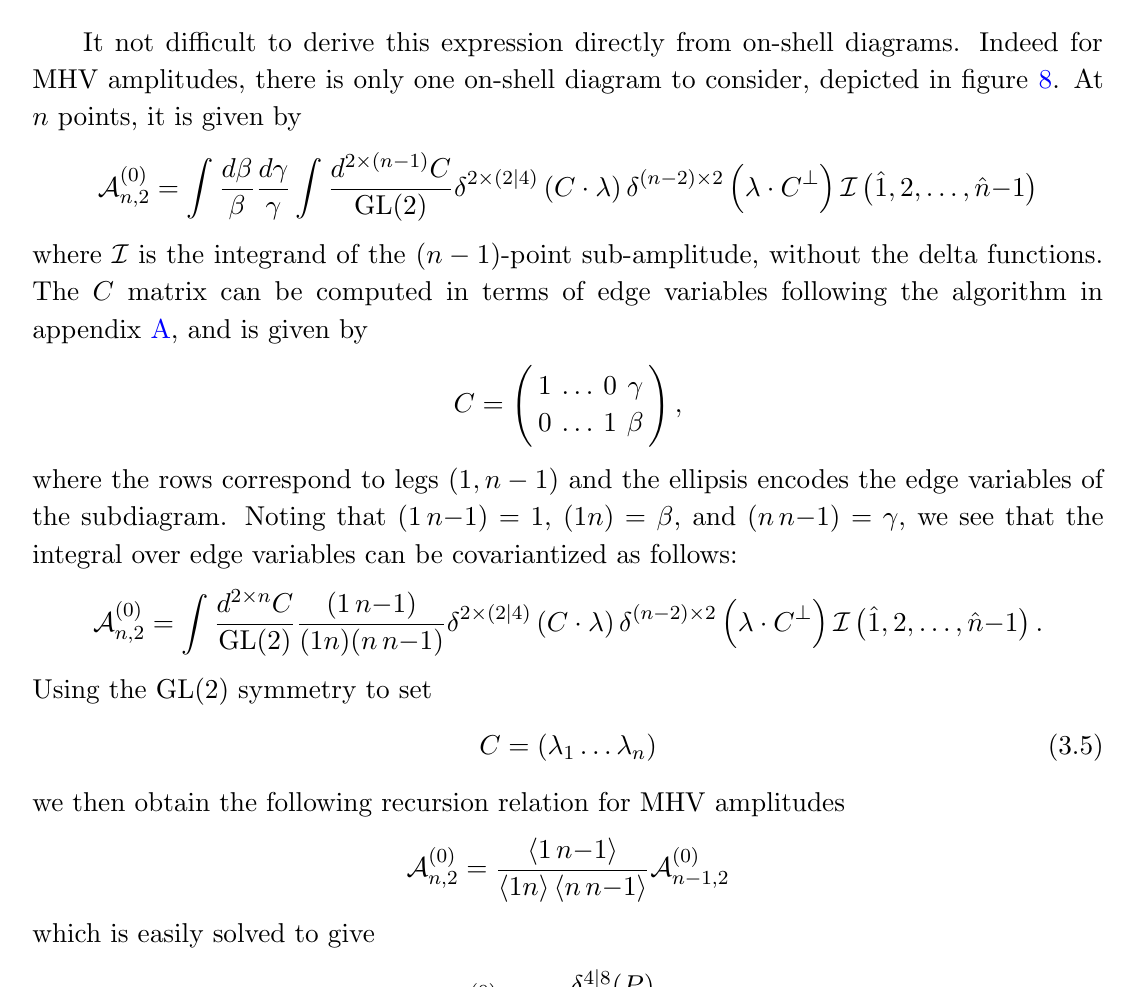
Figure 8 . On-shell diagram for tree-level n -point MHV amplitude in N = 4 SYM in terms of ( n (cid:0) 1)-point MHV